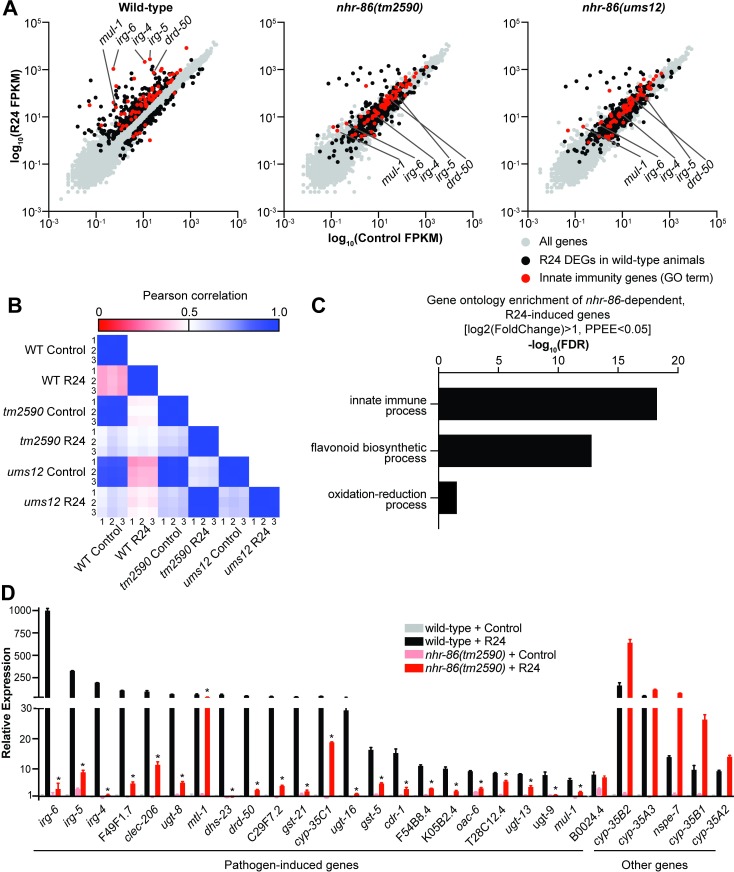
nhr-86 activates the transcription of innate immune response genes.(A) All data from the mRNA-seq experiment are presented on scatter plots. Genes that were differentially regulated upon R24 treatment in wild-type animals are shown in black (Fold change> 2, PPEE<0.05). These same genes are also highlighted in black in the nhr-86(tm2590) and nhr-86(ums12) scatter plots. Genes involved in innate immunity by Gene Ontology (GO) term are highlighted in red. (B) Pearson correlation coefficients are presented for all samples in the mRNA-seq experiment. (C) Gene ontology enrichment of the nhr-86-dependent, R24-induced genes identified in the mRNA-seq experiment are shown. (D) Results of NanoString nCounter gene expression analysis for 118 C. elegans genes performed on wild-type and nhr-86(tm2590) animals exposed to either R24 or control. The 28 genes that were induced 5-fold or greater in wild-type animals by R24 are presented. Data are the average of three replicates, each of which was normalized to three control genes, with error bars representing standard deviation and are presented as the value relative to the average expression from the replicates of the indicated gene in the baseline condition (wild-type animals exposed to control). * p<0.05 by student’s t-test for the comparison of the R24-induced conditions.